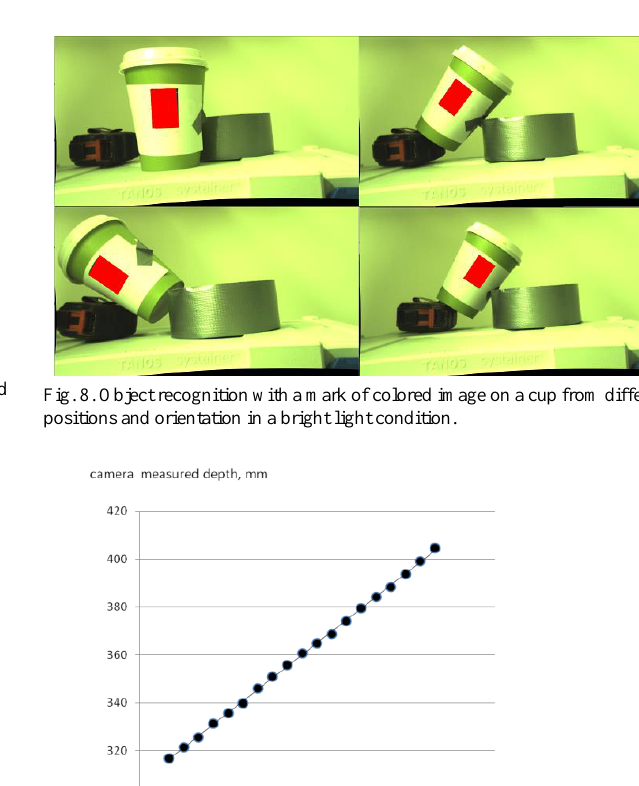
Fig. 7. Object recognition with a mark of colored image on a cup from different positions and orientation in dark condition.